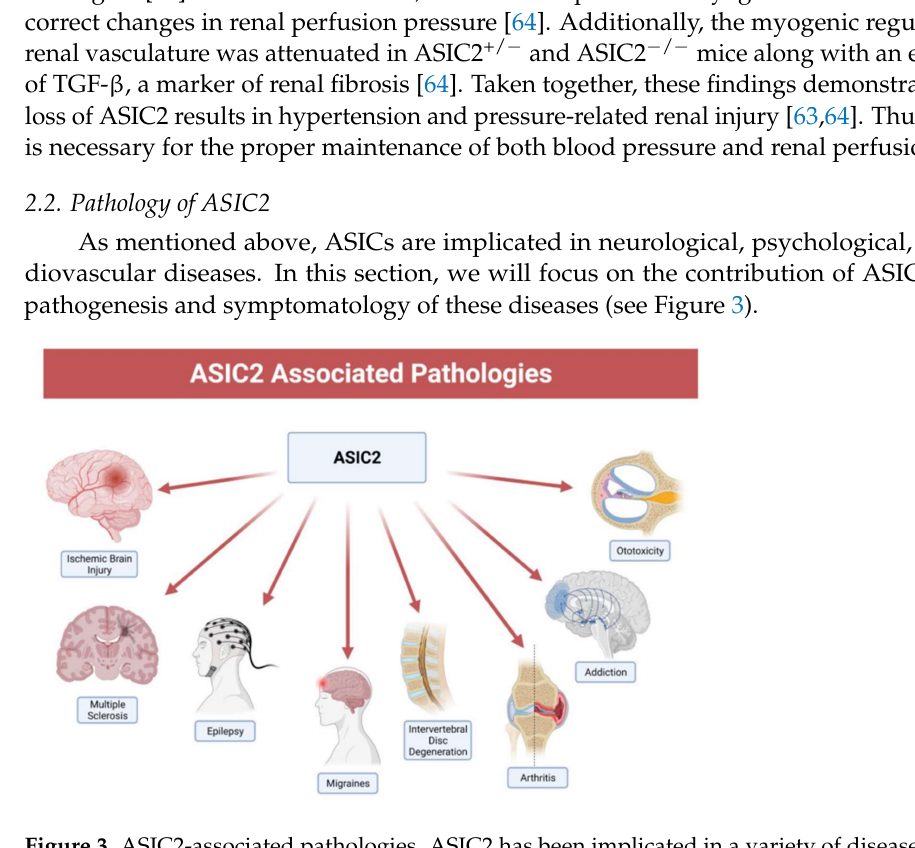
Figure 3. ASIC2-associated pathologies. ASIC2 has been implicated in a variety of diseases such as ischemia, multiple sclerosis, epilepsy, migraines, intervertebral disc degeneration, arthritis, addiction, and aminoglycoside-induced hearing loss. Although the relationship between ASIC2 and some of these diseases can be more established with future studies, there is promise that future medical interventions targeting ASIC2 can be beneficial. Adapted from “Complications of Hypertension” by BioRender.com (2021). Retrieved from https://app.biorender.com/biorender-templates, accessed